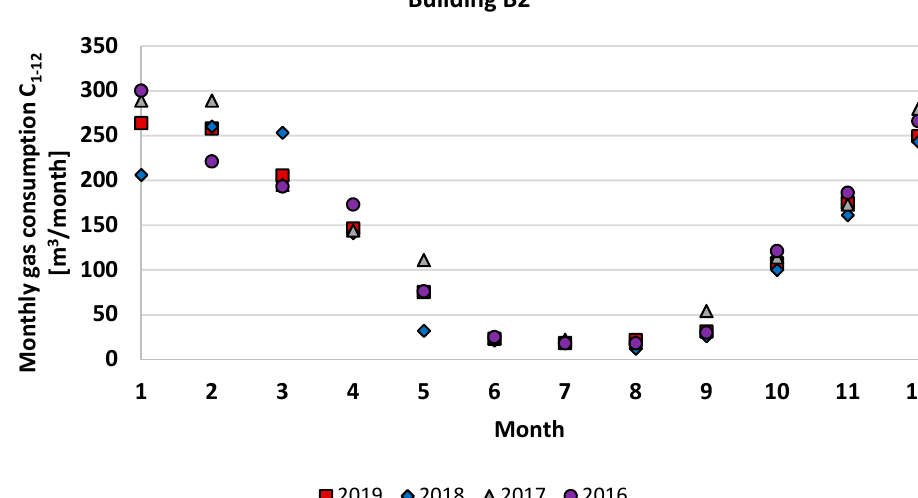
Figure 3. Monthly gas consumption in building B2.